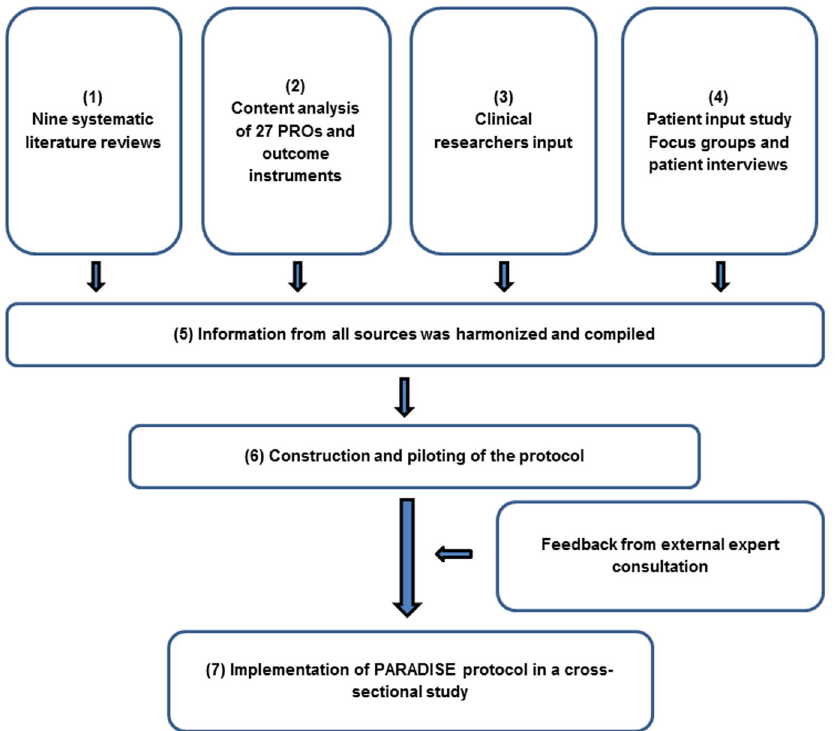
Fig 1. PARADISE approach with literature reviews, content analysis of outcome instruments, clinical input and qualitative study. PARADISE multi-method approach with systematic literature reviews, content analysis of patient-reported outcomes (PROs) and outcome instruments, clinical input and a qualitative study. Information from all sources was harmonized and compiled and a data collection protocol developed also including feedback from an external expert consultation. The protocol included all potentially relevant PSDs and their determinants across brain disorders. This protocol was implemented in a cross-sectional study.